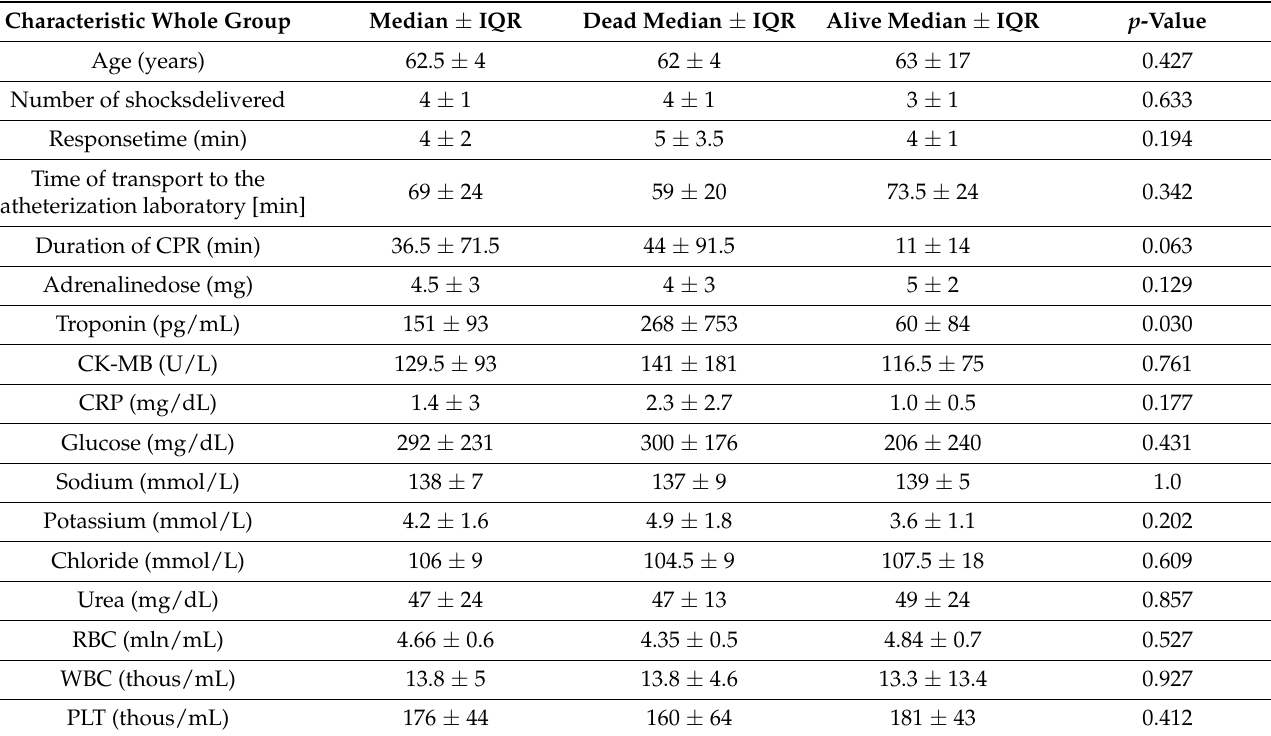
Table 1. Study group